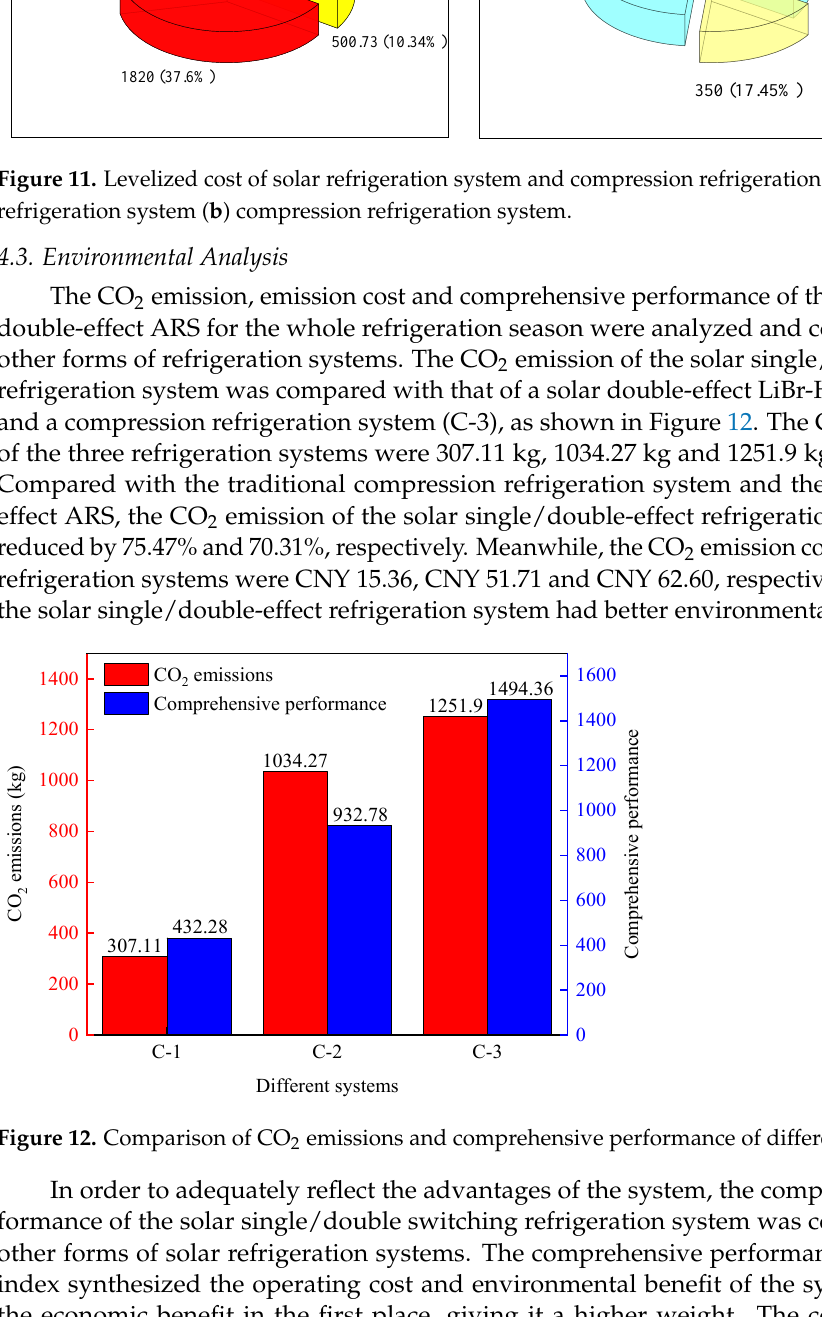
Figure 12. Comparison of CO 2 emissions and comprehensive performance of different systems.